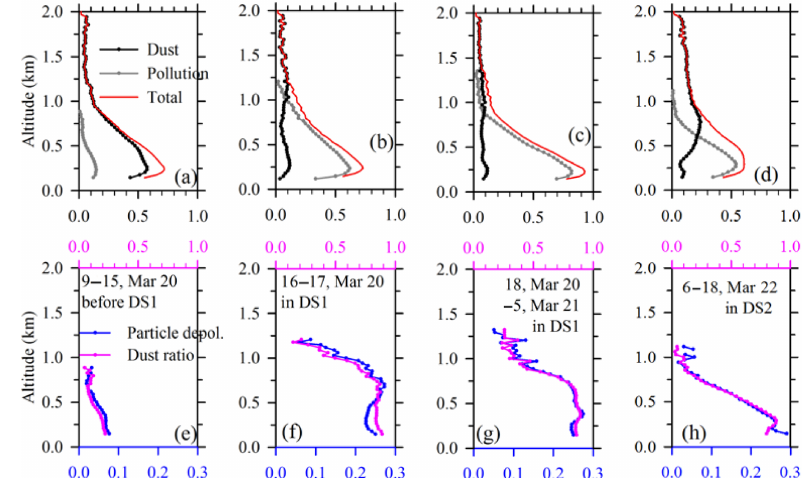
Figure 8. Vertical profiles of the average extinction coefficients of dust, pollution, and total particles (km − 1 ) , particle depolarization ratios (Particle depol., unitless), and the ratio of the dust extinction in the total particle extinction (Dust ratio, unitless) in four periods of 09:00– 15:00LST on 20 March (before DS1), 16:00–17:45LST on 20 March (before the highest PM 10 concentration in DS1), 18:00LST on 20 March–04:45LST on 21 March (during the highest PM 10 concentration in DS1), and 06:00–18:00LST on 22 March in